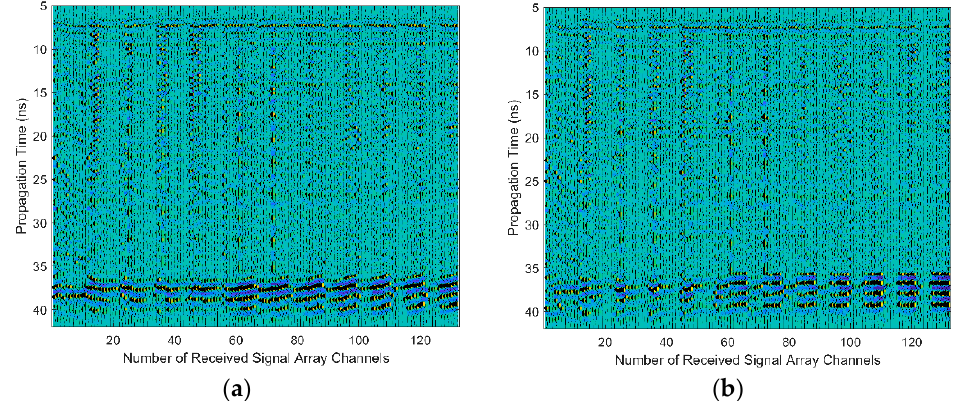
Figure 7. Two single-station measured data after the optimal Equation (36): ( a ) for Figure 5a, and ( b ) for Figure 5b, respectively.